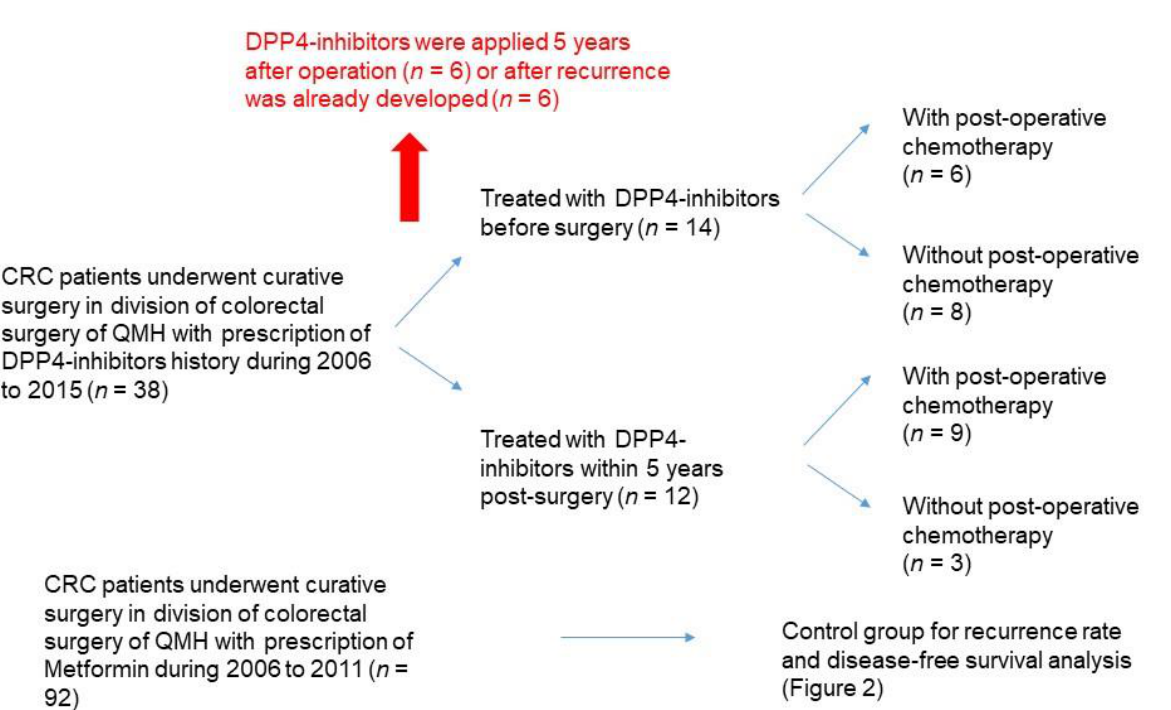
Figure 1. Patient selection in the study. CRC, colorectal cancer; DPP4, Dipeptidyl Peptidase 4; QMH, Queen Mary